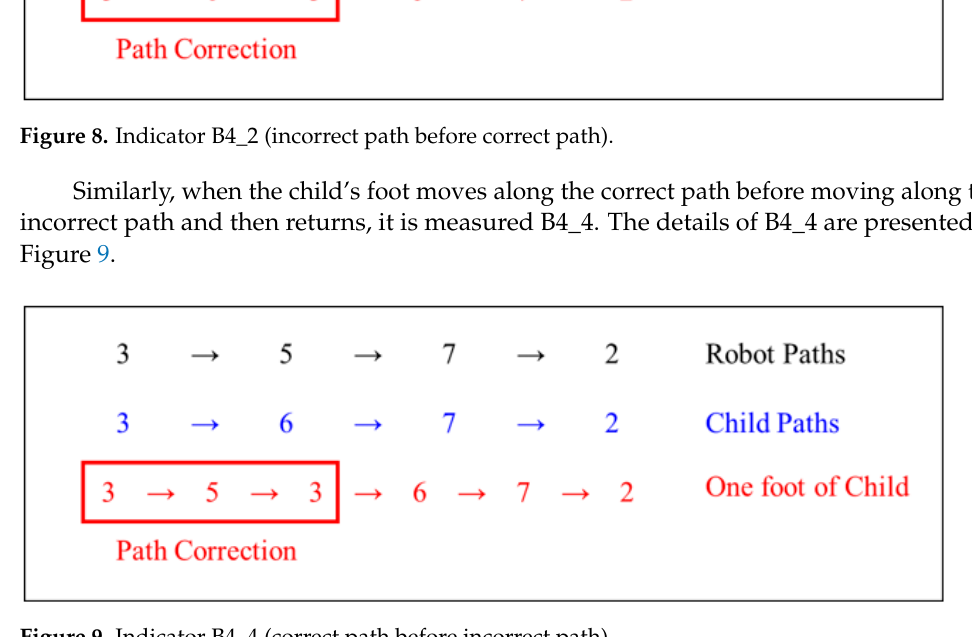
Figure 9. Indicator B4_4 (correct path before incorrect